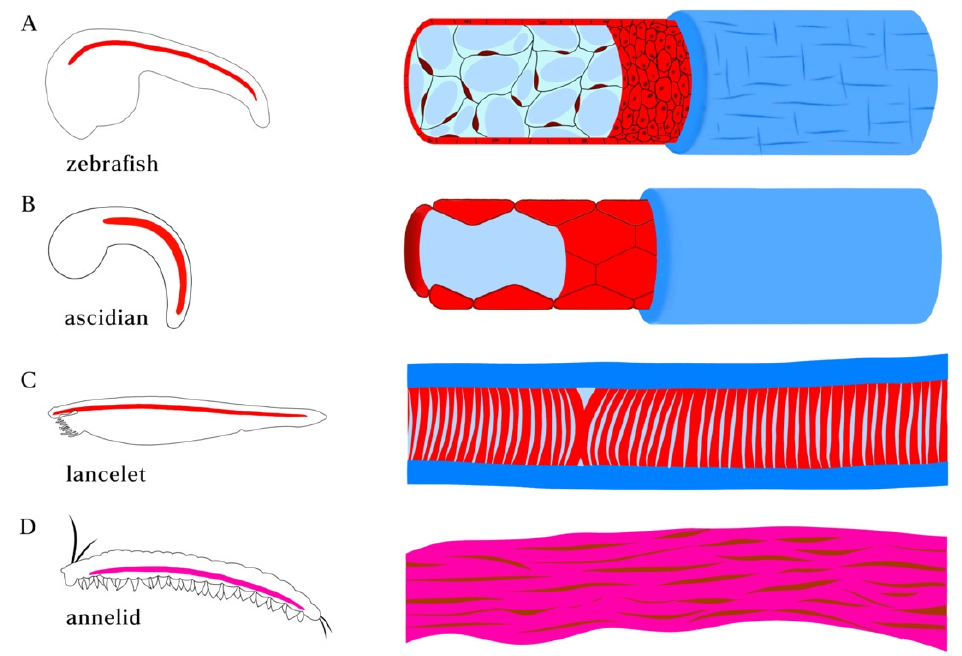
Figure 2. Morphologies of notochord in chordate species and axochord in annelid. ( A ) notochord in zebrafish embryo. The notochord in vertebrates is composed of a rod of highly vacuolated cells surrounded by epithelial (teleosts) or acellular (amniotes) sheath. ( B ) Ascidian ( Ciona ) notochord. The developing single-filed notochord cells move in polarized direction and undergo tubulogenesis, forming a long continuous fluid-filled lumen surrounded by sheath composed of basal lamina and a layer of circumferentially arranged extracellular matrix filaments. ( C ) Notochord in amphioxus lancelet. The muscular notochord cells contain vacuoles flanked by muscle fibers and surrounded by layers of laminin and collagen-based sheath. ( D ) Annelid axochord. The proposed homologous axochord is composed of a paired axial muscle spanning the ventral midline of annelid worms.